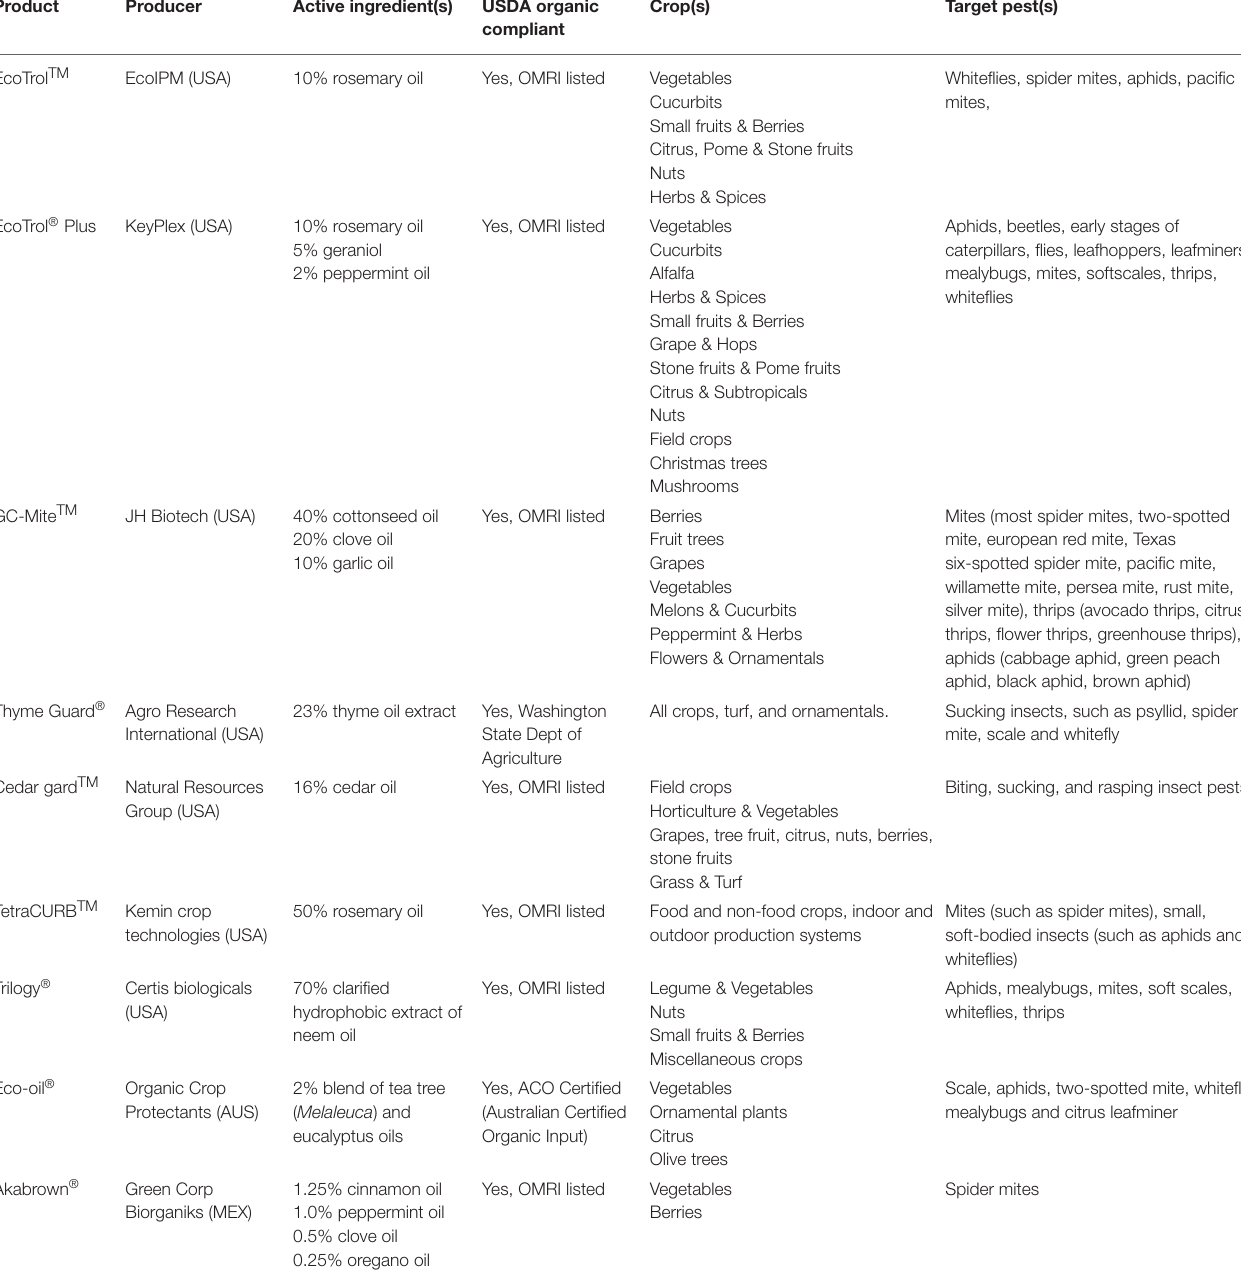
TABLE 3 | Currently available commercially formulated insecticides/miticides based on plant essential oils. Product